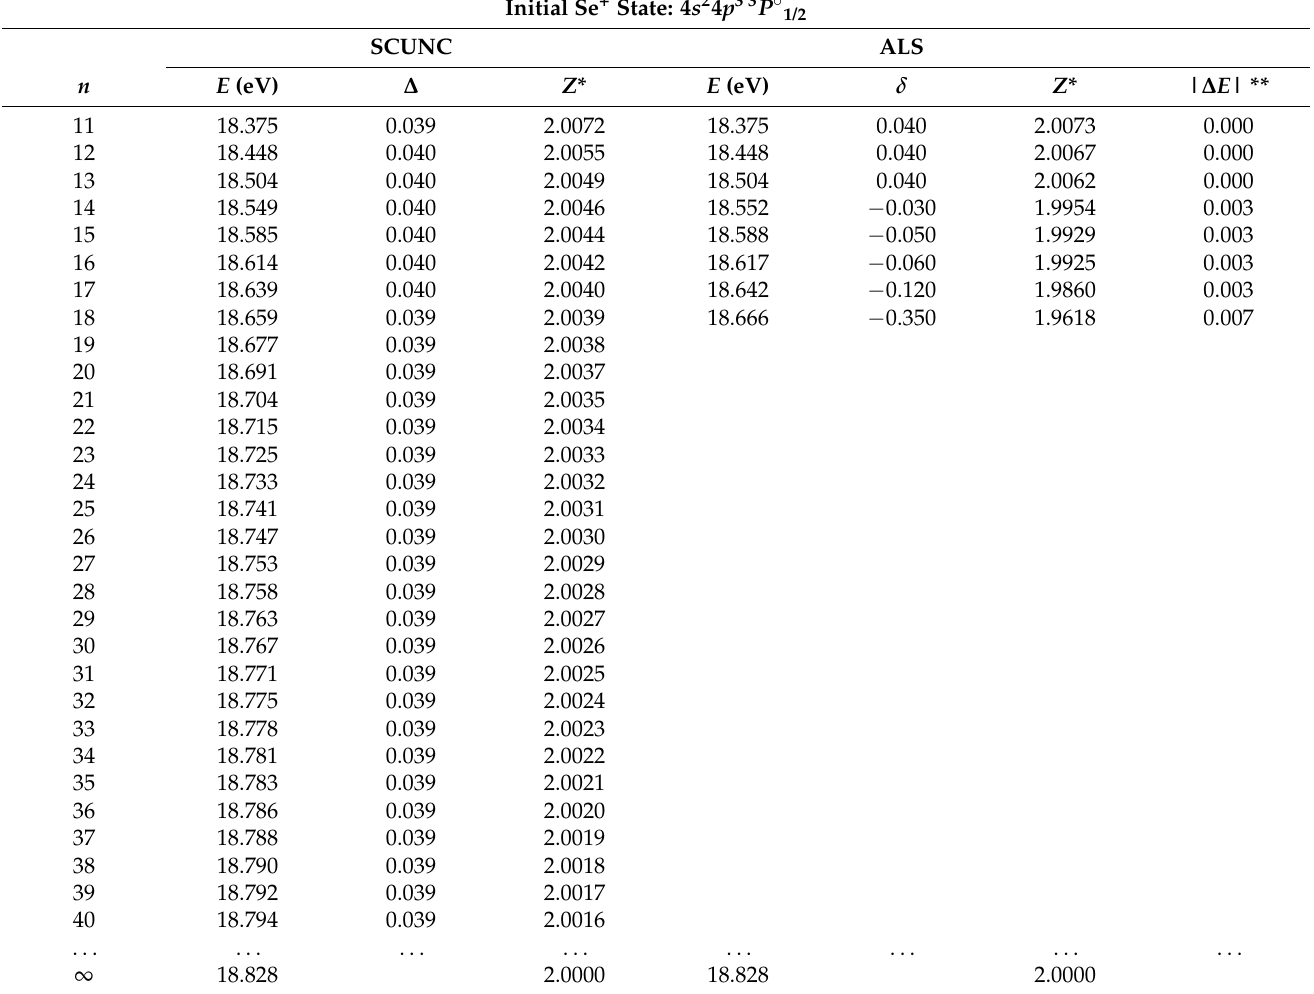
Table 3. Energy resonances ( E ), quantum defect ( δ ) and effective charge ( Z *) of the 4 s 2 4 p 2 ( 3 P 2 ) nd Rydberg series originating from the 4 s 2 4 p 3 2 P ◦ 1/2 metastable state of Se + converging to the 3 P 2 series limits in Se 2+ . The present results (SCUNC) are compared with the experimental data from ALS measurements [6]. The uncertainties in the experimental energies are stated to be ± 0.010 eV, f 1 ( 3 P 2 ; 2 P ◦ − 0.072 ± 0.042 with ν = 1/2 ) =